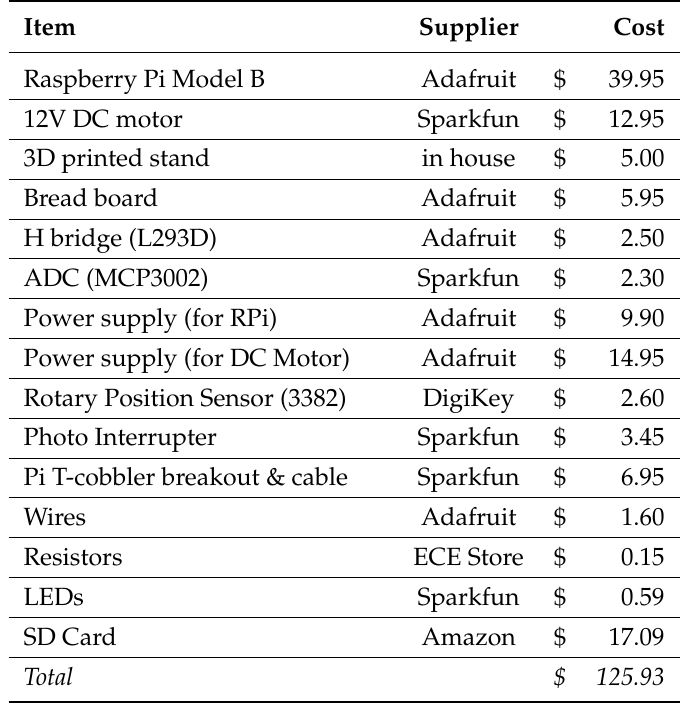
Figure 1. Complete DC Motor Kit. Table 1. Components of the